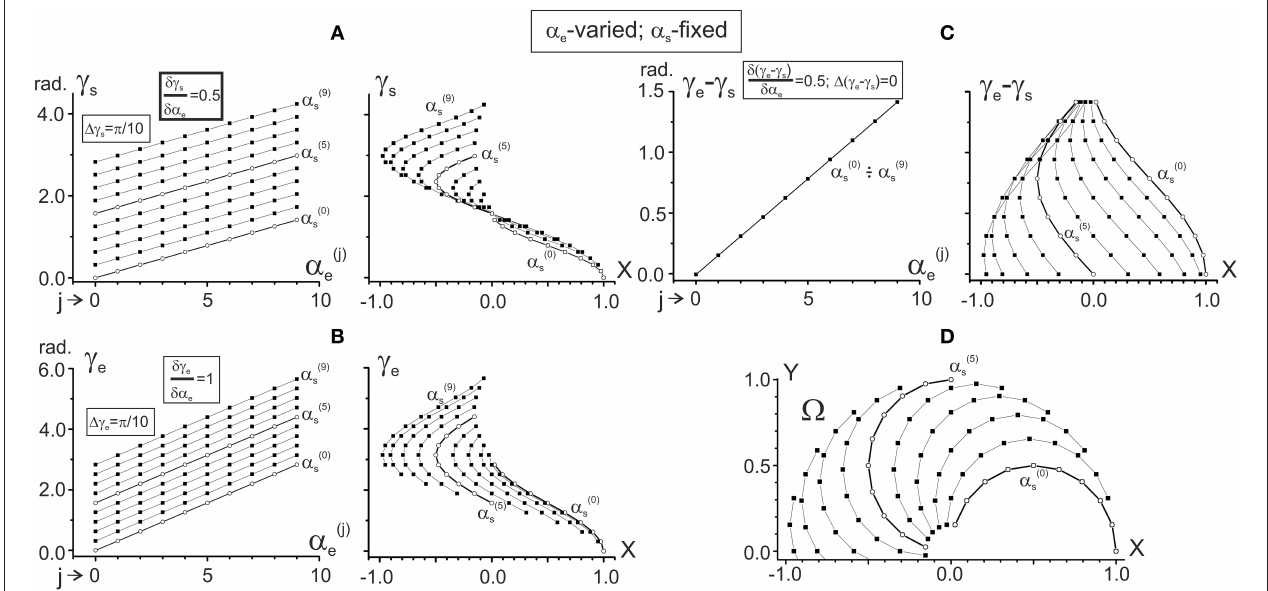
FIGURE 3 | Changes in the characteristic angle s γ s and γ e and their difference in dependence on α e provided that α s is fixed. The steps of the joint angles are the same as in Figure 2 ; successive procedures of numerical analysis are presented in Table 1 , right column. The right columns in (A–C) present the same data as in the left ones after changing the end-point angles by their projections on the X-axis of the working space (cid:127) (shown in D ). For ease of distinguishing, the traces α (0) s and α (5) s are marked by open circles. Quantitative information about slopes of the characteristics and distances between them is placed in squares at the correspondent panels. Note the same ordinate calibrations in the paired plots of (A–C) and the conformity between the points in these plots and their positioning within the working space (cid:127) (D)